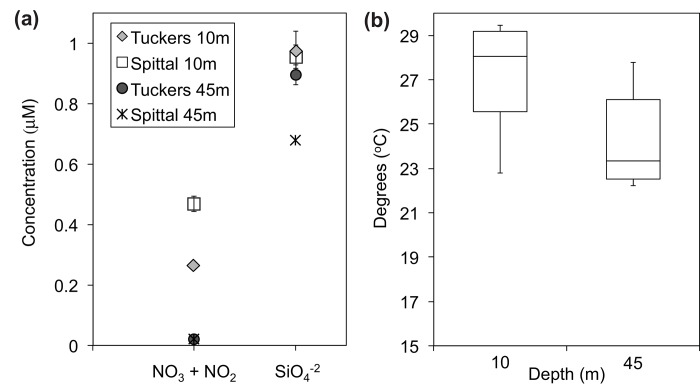
Nutrient Concentration and Temperature by Depth.(a) mean (±SD) concentration (μM) of nitrate (NO3) + nitrite (NO2) and silicate (SiO4
-2) on shallow (10m; n = 4 per site) versus mesophotic sites (45m; n = 4 per site) from water samples collected September 5, 2015 (NO3 + NO2, p<0.0001, Tuckers, p = 0.019, Spittal; SiO4
-2, p = 0.001, Tuckers, p = 0.058, Spittal; Student’s t-tests); (b) box blot of seawater temperature at shallow (10m) and mesophotic (45m) sites showing median values (solid horizontal line), 25th and 75th percentile values (box outline), and minimum and maximum values (whiskers) recorded between July 2014 and January 2015 from 6 paired shallow (10m) and mesophotic (45m) survey sites (2 dives per site); Rita/XL, Coopers, Tuckers, Spittal, Devonshire, and Hungry Bay (p<0.0001, Students t-test, n = 6).